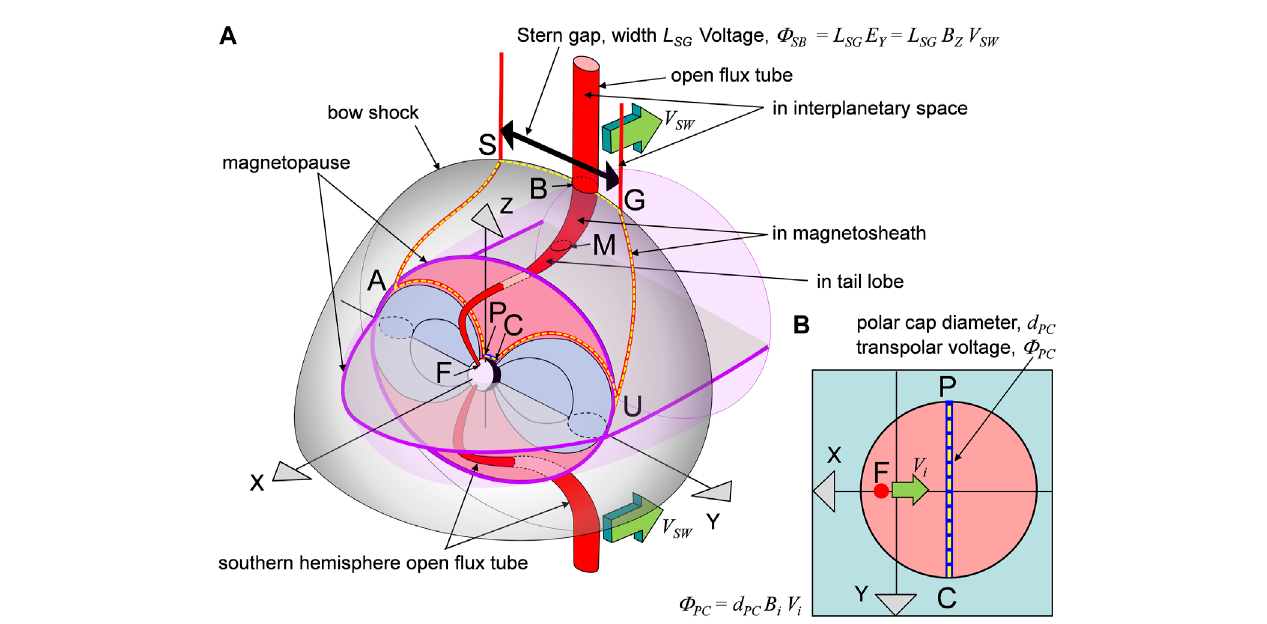
FIGURE 3 (A) . Schematic of inductive decoupling of the “Stern Gap” voltage across open field lines in interplanetary space, Φ SG and the transpolar voltage in the ionosphere Φ PC . The magnetosphere is here viewed from northern middle latitudes in the mid-afternoon sector. The loops PASGUC (shown by the yellow dashed line) and PAUC (enclosing the northern tail lobe cross section shaded pink) are fixed in the XYZ GSM frame, where P and C are the dawn and dusk extremes of the northern ionospheric polar cap, AP and UC are field-aligned in the magnetosphere, SA and GU are field aligned in the magnetosheath, SG lies in the bow shock and AU in the tail magnetopause. The red flux tubes are open field lines and the northern-hemisphere tube threads the bow shock at B and the magnetopause at M and has an ionospheric footpoint, F. The solar wind flow is in the − X direction at speed V SW . (B) Is a view looking down (in the − Z direction) on the northern hemisphere polar cap in which the antisunward ionospheric convection velocity of the footpoint F is V i .